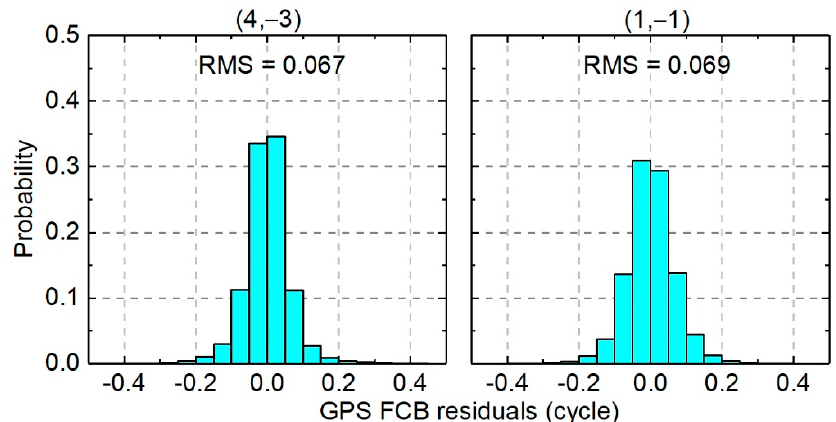
Figure 7. Distribution of the a posteriori residuals of the GPS FCB estimation with integer linear-combined float ambiguities. RMS, root mean square.